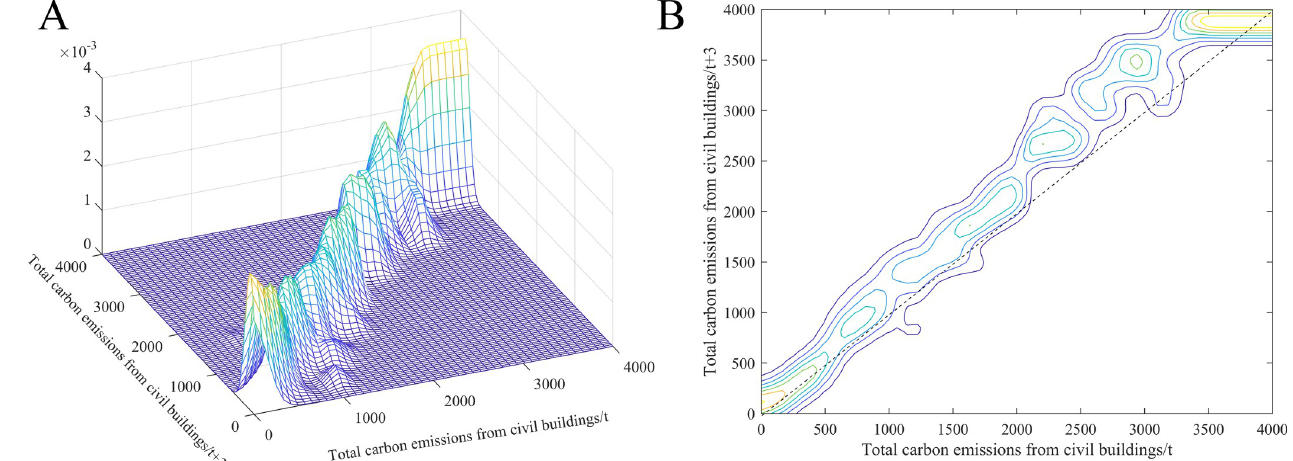
Fig 5. Dynamic stochastic kernel density curve (A) and density contour (B) of total carbon emissions from civil buildings.